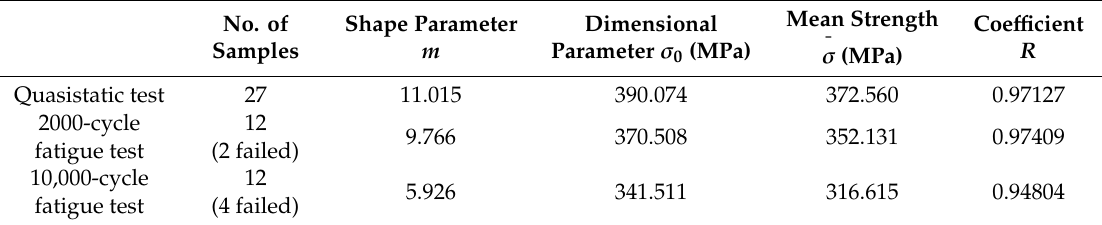
Table 2. Model parameters of the two-parameter Weibull distribution models based on maximum-likelihood